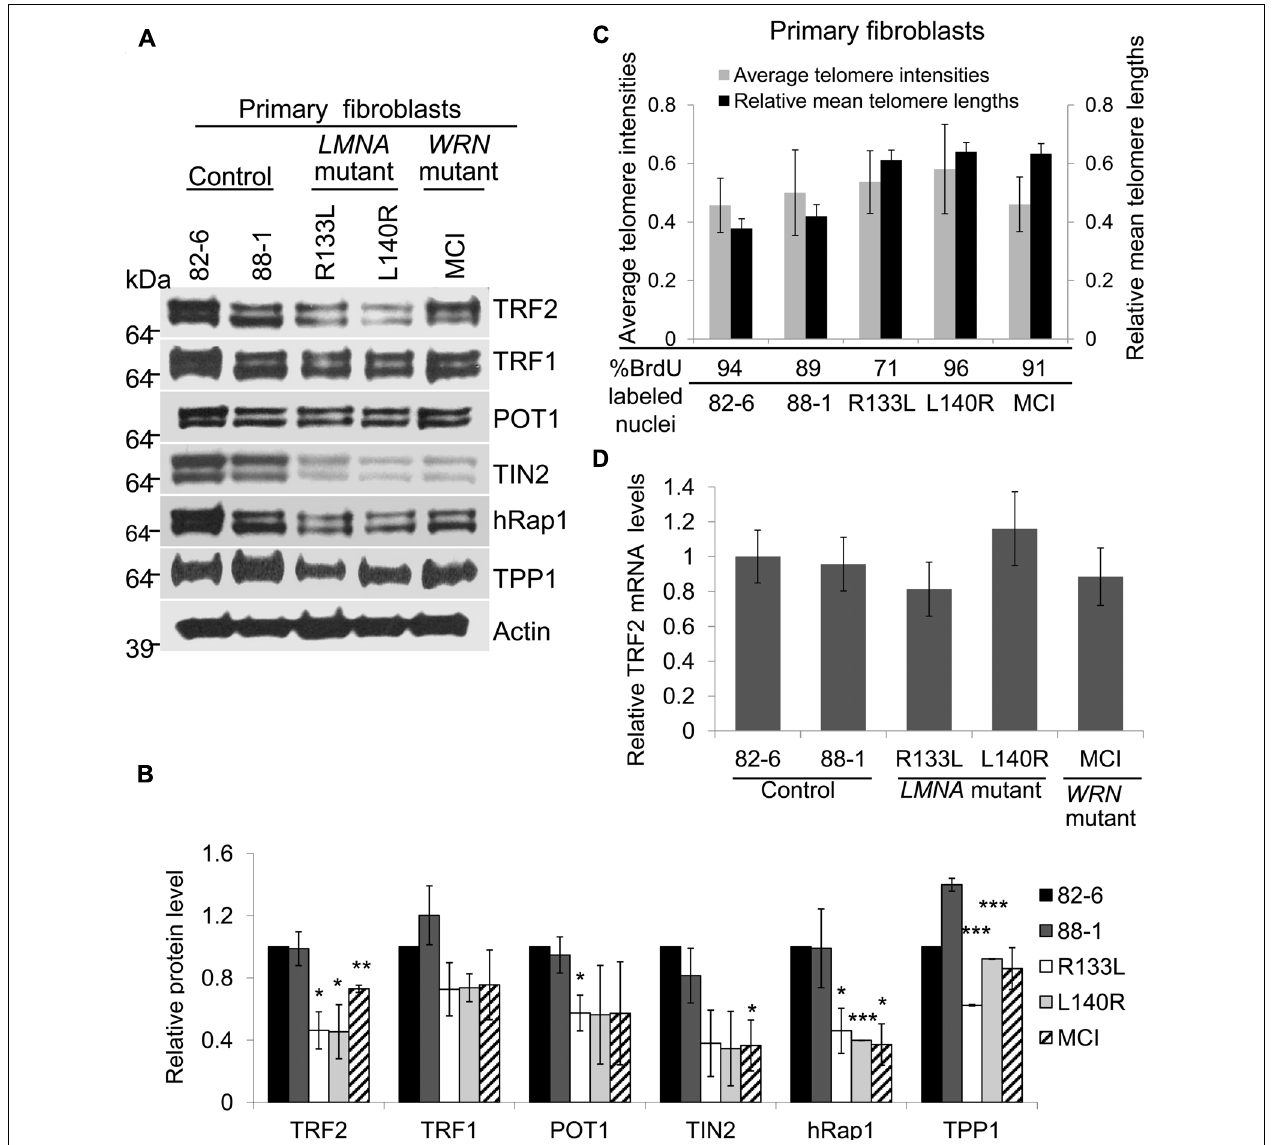
mutant fibroblasts.The signal intensities were analyzed by Q-FISH using a telomere-specific peptide nucleic acid (PNA) probe. A centromere PNA probe was used as an internal standard. Approximately 70 cells were analyzed for each cell line.The relative mean telomere lengths ( ± s.d.) in fibroblasts were measured by quantitative PCR. (D) TRF2 mRNA expression in normal, LMNA mutant and WRN mutant fibroblasts. TRF2 mRNA expression was detected by qRT-PCR. GAPDH mRNA expression was used as an internal standard. Data are presented as mean ± s.d. from three independent experiments. Control (82-6) values were taken as